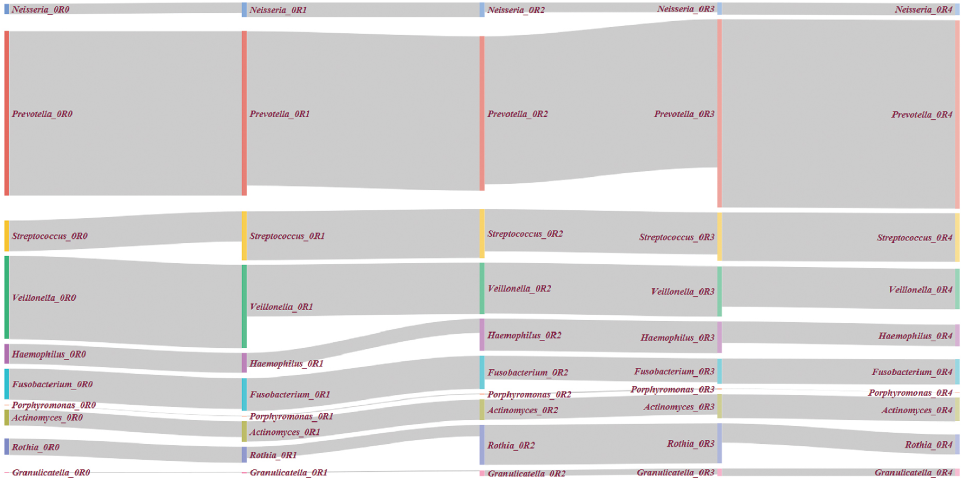
Figure 3: Illustration of four timepoints from the microbial community of the tongue as described in Caporaso et al. [32]. The taxonomy level is genus. The largest absolute genera and the biggest absolute and relative changes over time are visi- ble: Prevotella as largest genus and Rothia, and Granulicatella with large changes (large bars, with small lines from left to right, e.g. “ Rothia_2 ” and “ Rothia_3 ”